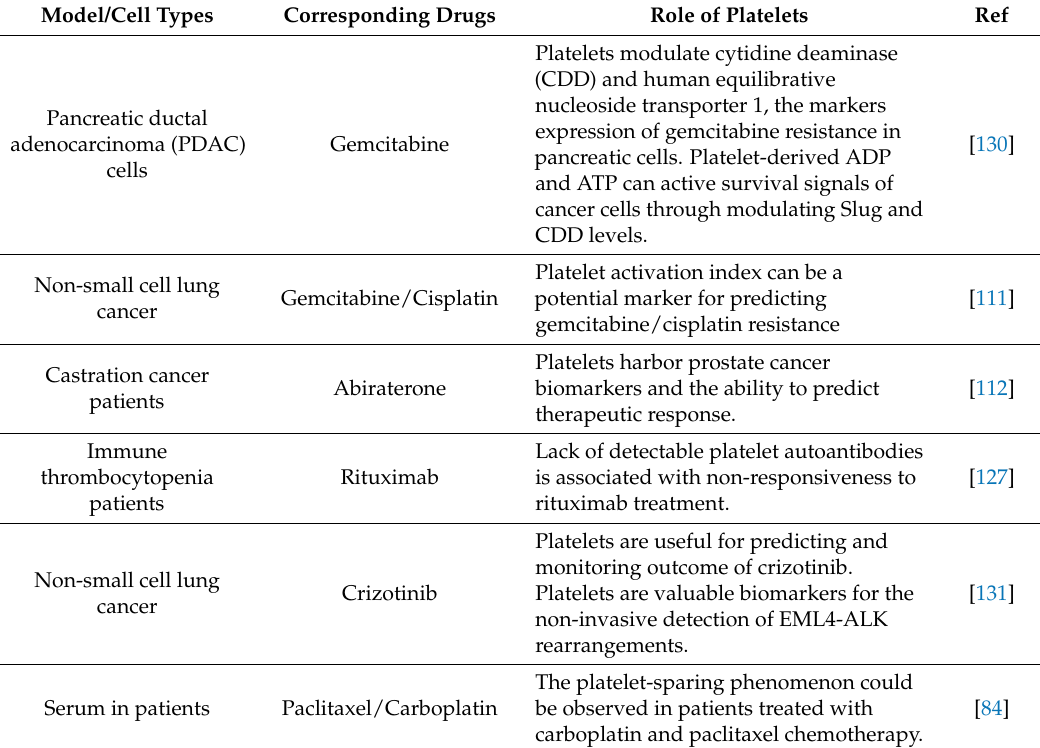
Table 2. The contributions of platelets to the drug resistance of cancer